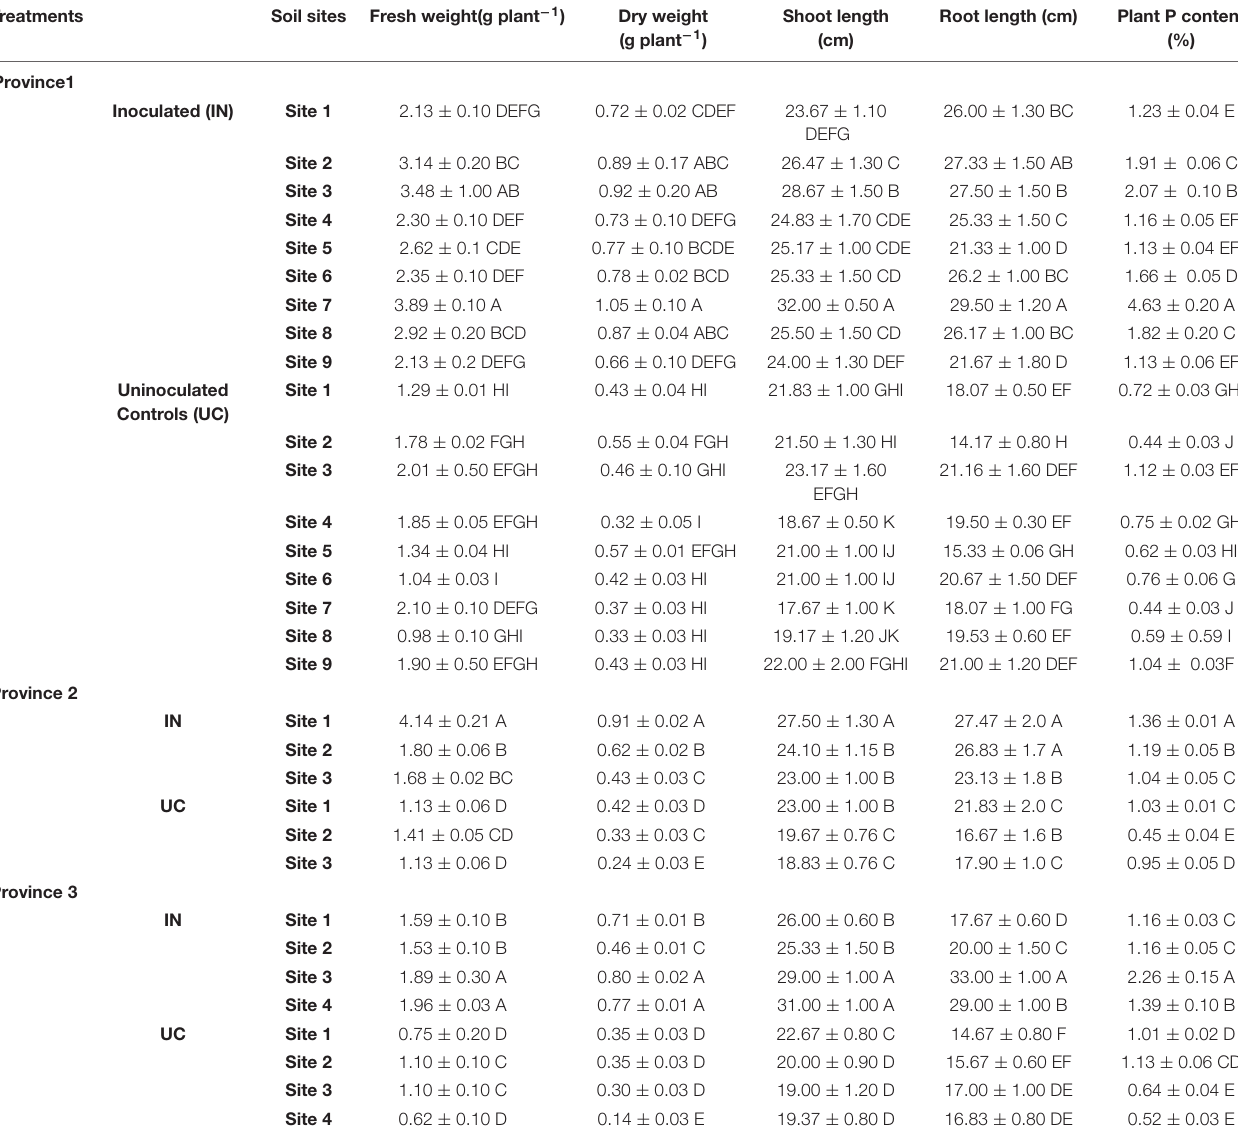
TABLE 4 | Effect of phosphate-solubilizing bacteria on growth parameters of wheat varieties grown in soils of different agro-ecological zones.